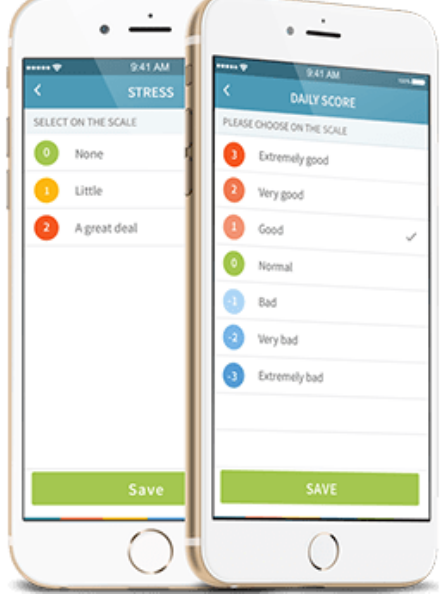
Figure 1. Examples of the self-assessment screenshot from the Monsenso